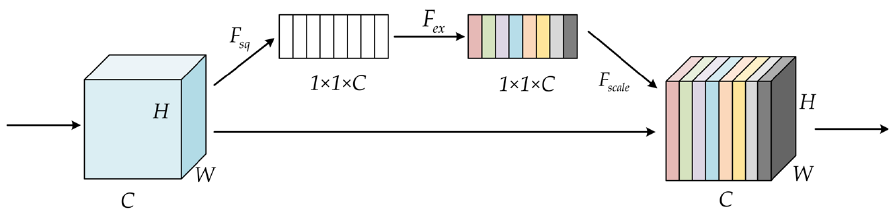
Figure 7. SENet model structure.